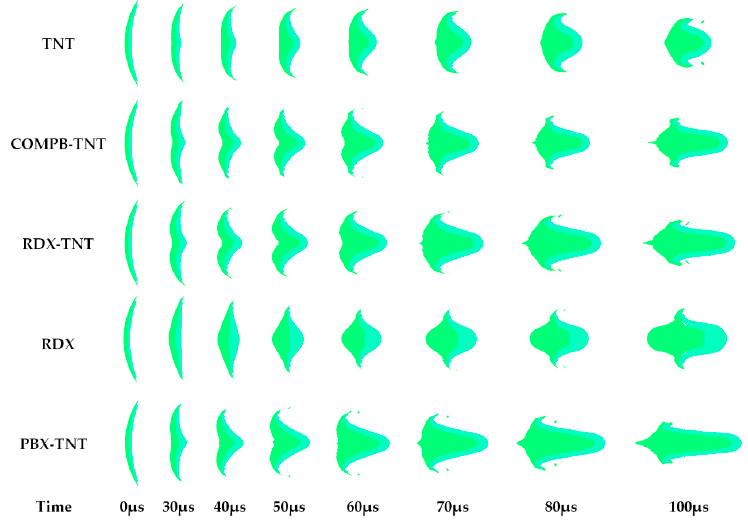
Figure 4. EFP forming processes in different shaped charge structures.